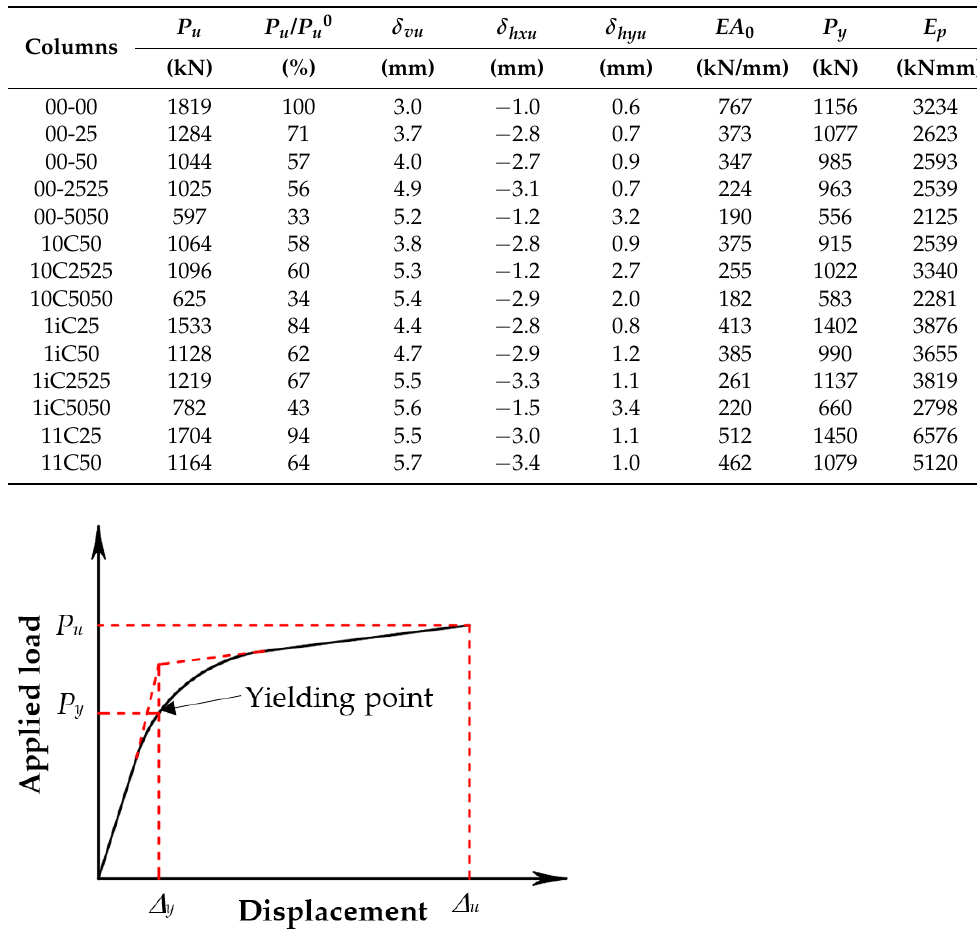
Table 3. Test result.